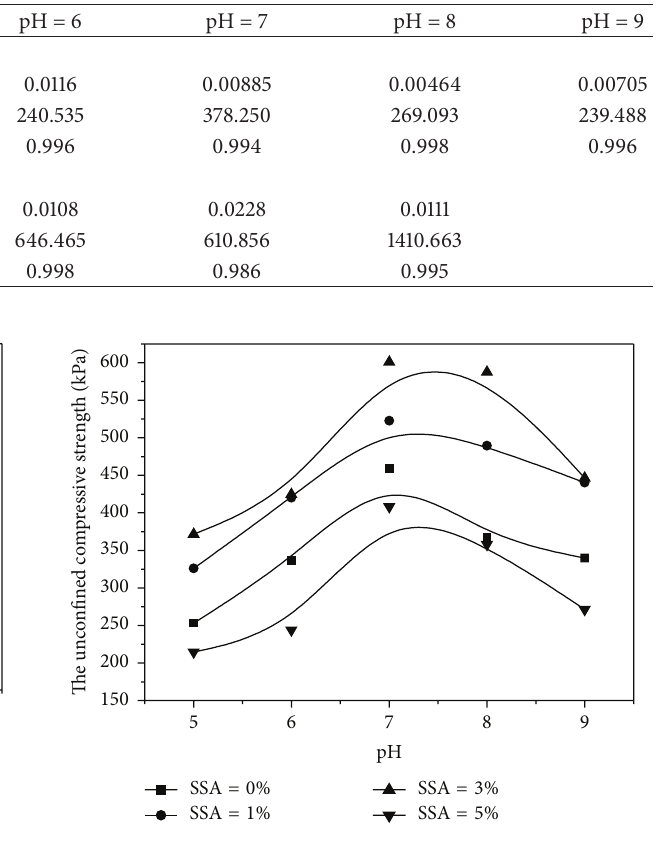
Figure 8: The unconfined compressive strength of the modified clay containing